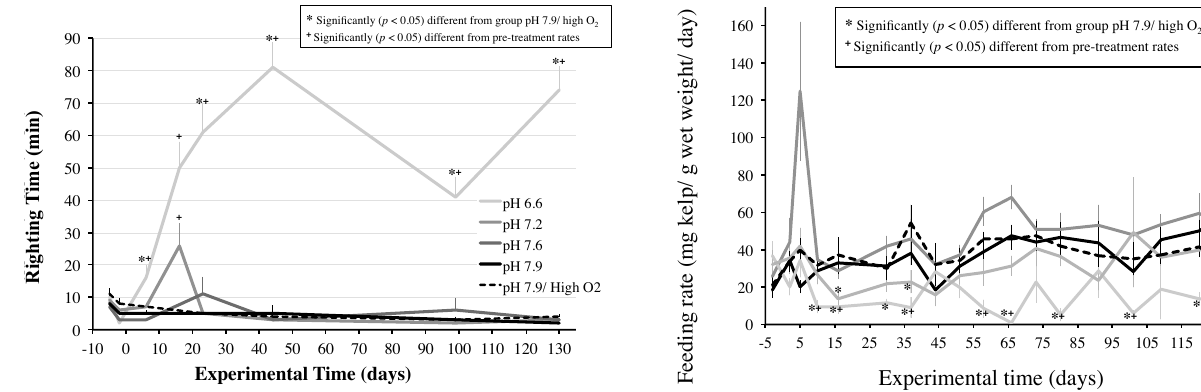
Figure 3. Righting time for S. fragilis is shown before and during exposure to extreme (pH 2 Fig. 3. Righting time for S. fragilis is shown before and during ex- posure to extreme (pH 6.6), high (pH 7.2), moderate (pH 7.6) and 6.6), high (pH 7.2), moderate (pH 7.6) and control (pH 7.9) p CO 2 at in situ O 2 levels, and to 3 control (pH 7.9) p CO 2 at in situ O 2 levels, and to control p CO 2 control p CO 2 (pH 7.9) at 100% air saturation. Times are shown as mean ± SEM. 4 (pH 7.9) at 100% air saturation. Times are shown as mean ± SEM.